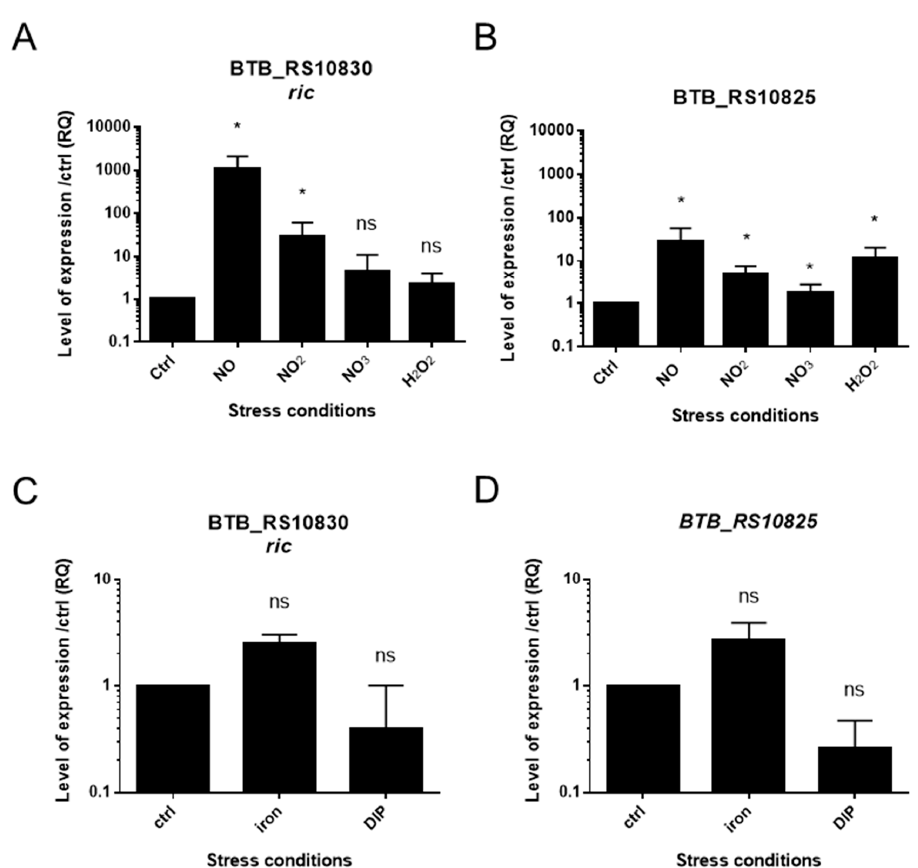
Figure 5. Gene expression analysis by RT-qPCR during different stresses. Gene expression of ric and BTB_RS10825 which encodes the large subunit of the nitrite reductase under each condition was normalized to the reference gene rpoA and to the non-stressed condition (Ctrl) (RQ: relative quantification) . ( A , B ) Bacteria were stressed for 15 min with 10 µM of NO, 2.5 mM of sodium nitrite, 20 mM potassium nitrate, 0.03% of hydrogen peroxide, respectively . ( C , D ) Bacteria were grown for 1 h in an iron-free medium (RPMI). They were then incubated for 15 min in the presence of excess iron (81 µM of iron citrate) or an iron-specific chelating agent (4,4 µM 2,2 ′ -dipyridyl (DIP)) or RPMI medium alone. Average and standard deviation from three independent experiments are shown. Statistically significant increases of expression in comparison to the control are indicated with asterisks (Mann-Whitney; ns, not significant, * p -value <